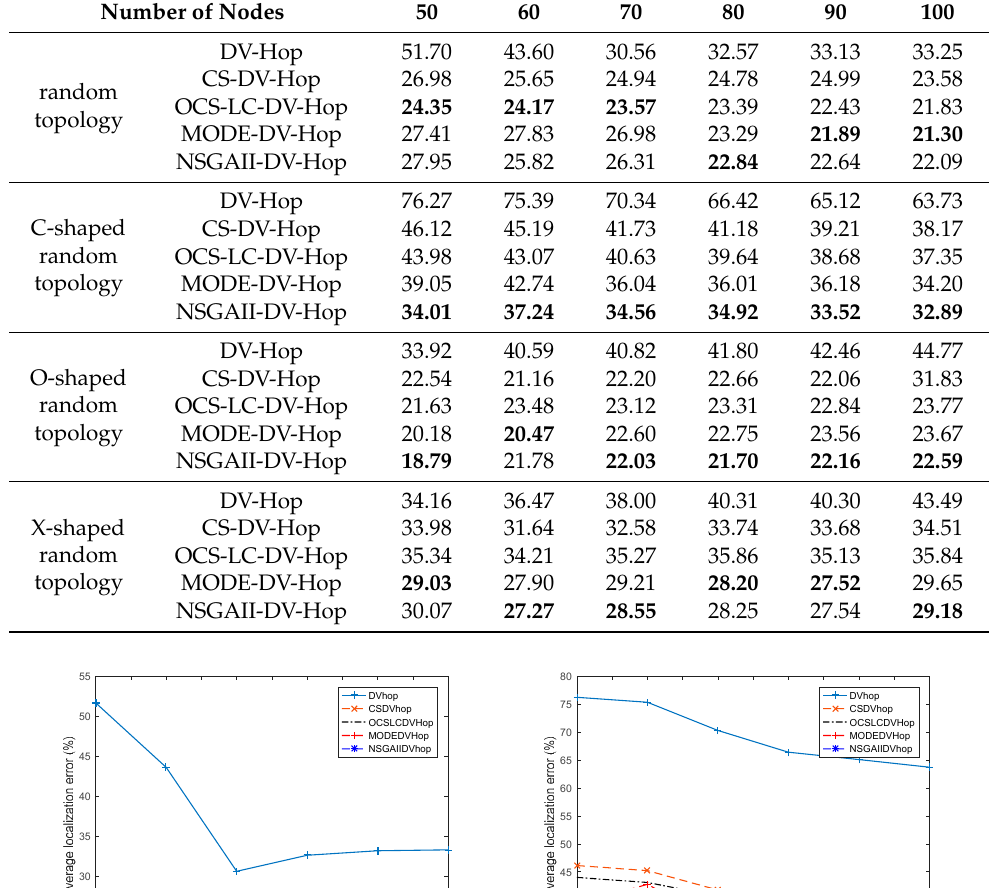
Table 3. ALE of different algorithms in different network topologies and number of nodes. Number of Nodes